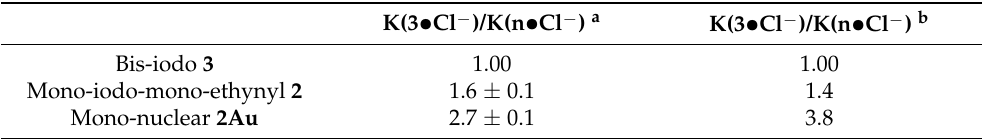
Table 3. Values of the binding constants’ ratios determined using the results of ITC experiments and pairwise-competitive binding experiments.